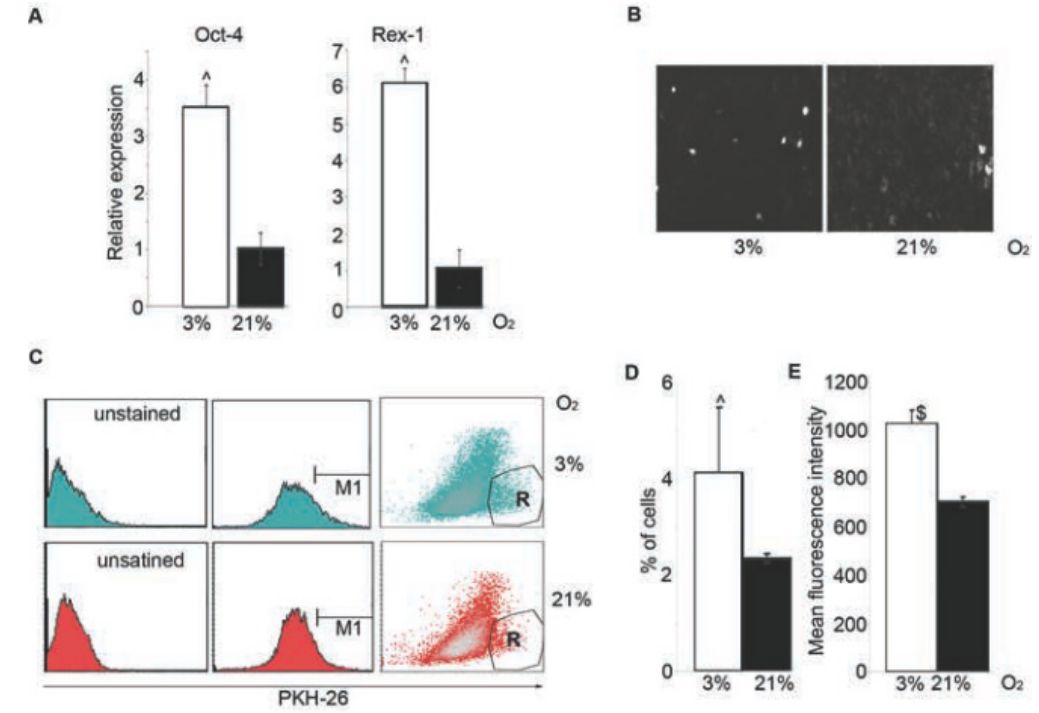
Figure 5. Effect of 3% O on BMSC stem cell markers expression and amount of 2 quiescent cells. ( A ) Expression of Oct-4 and Rex-1 in BMSC at day 7; ( B ) Pictures of BMSC observed with fluorescent microscope upon PKH-26 staining; ( C ) FACS histograms of BMSC upon PKH-26 staining. R region (=M1 region) represents cells with the highest PKH-26 fluorescence; ( D ) Percentage of cells included in R region from C; ( E ) Mean fluorescence intensity of cells gated by R region. The difference is statistically significant for cells cultured in 3% and 21% O : ^, p < 0.05, $, p < 2